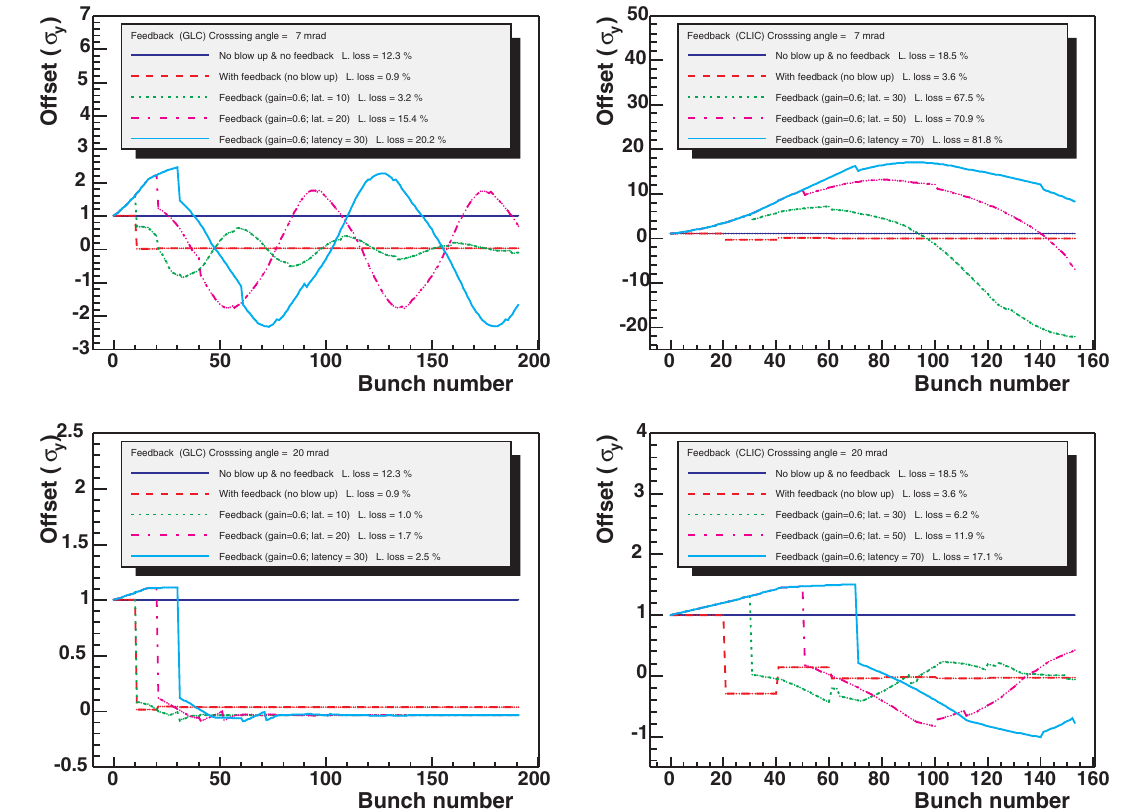
. A feedback system latency of 10 (30) for the GLC y